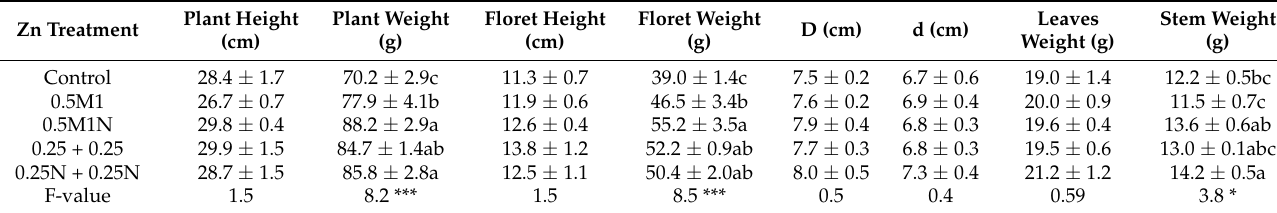
Means in a column with different letters were significantly different (* p < 0.05; *** p < 0.001) according to the Fischer’s protected LSD (least significant difference) test for the Zn